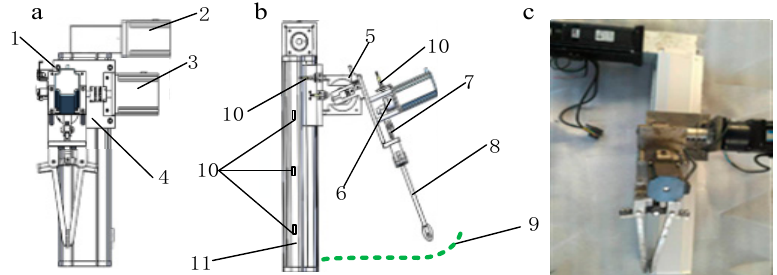
Figure 2. Sweet Potato Transplanting Robot. ( a ) Front View ( b ) Side View ( c ) Physical View. (1) Seedling claw motor; (2) sliding table drive motor; (3) rotary motor; (4) moving platform; (5) proximity switch; (6) eccentric wheel; (7) adjusting push rod; (8) seedling claw; (9) planting track; (10) photoelectric switch; (11) sliding platform module. where x 1 ( t ), y 1 ( t ) is the coordinate of joint 1 at time t ; ϕ ( t ) is the angle of joint 2 at time t , and l is the length of link 2.